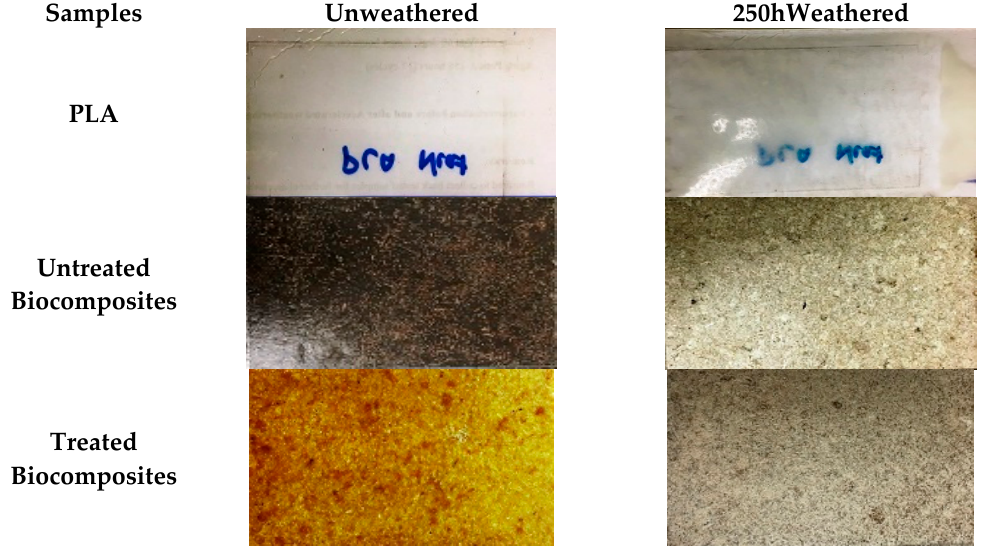
Figure 2. Images of unweathered and accelerated weathered untreated and treated CF/PALF/PLA biocomposites and PLA